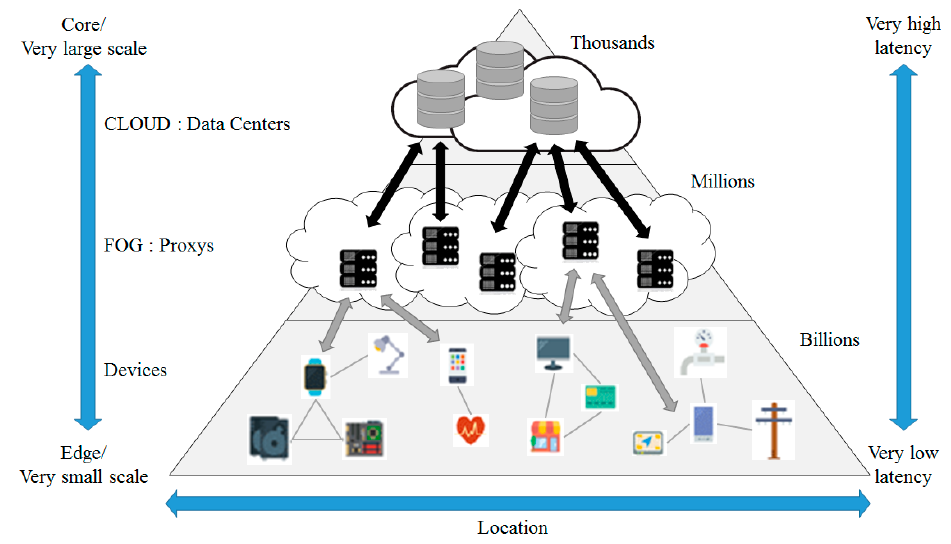
Figure 3. The Structure of Fog Computing.